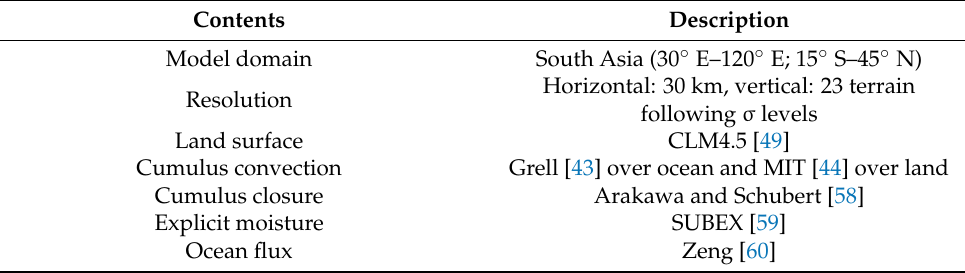
Table 1. Overview of the model considered for this